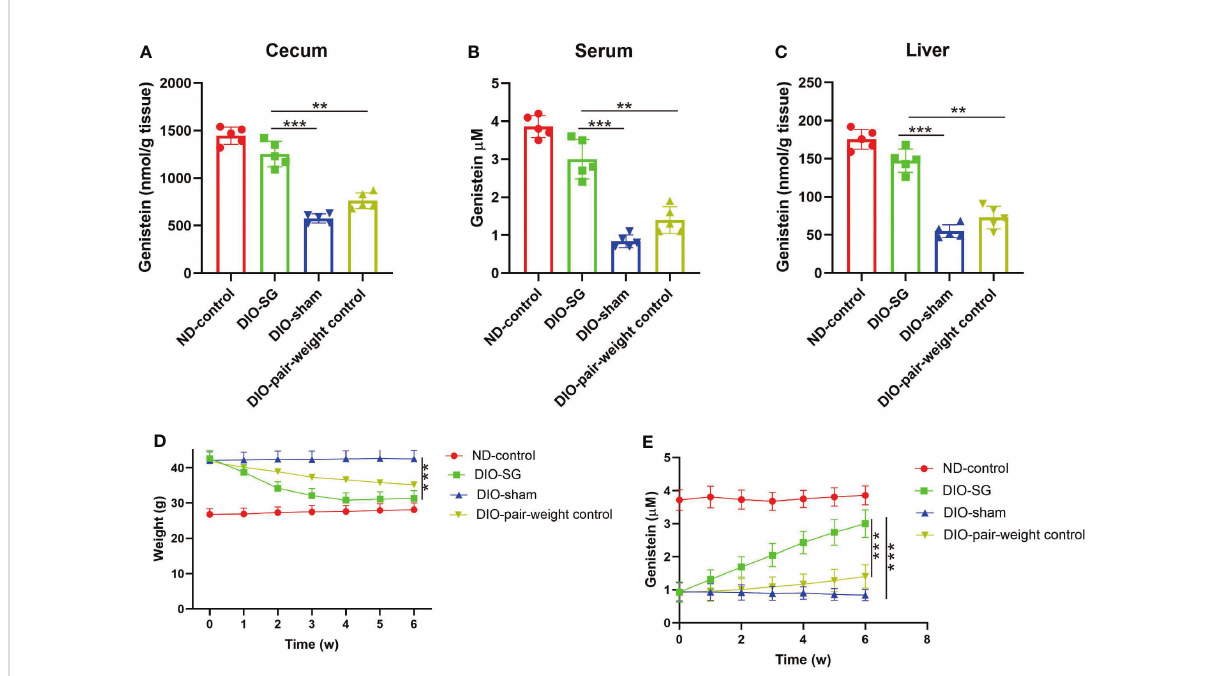
FIGURE 3 Abundance of genistein is decreased in mice with obesity and could be restored by SG. (A – C) The concentration of genistein in the cecum, serum, and liver in different groups. n = 5 in each group. (D) The changes of body weight in each group. (E) The changes of plasma levels of GE in each group. The details of the group were introduced in the “ Methods ” part. ANOVA test was used to compare the differences among the groups. Data are presented as mean ± SEM, * p <